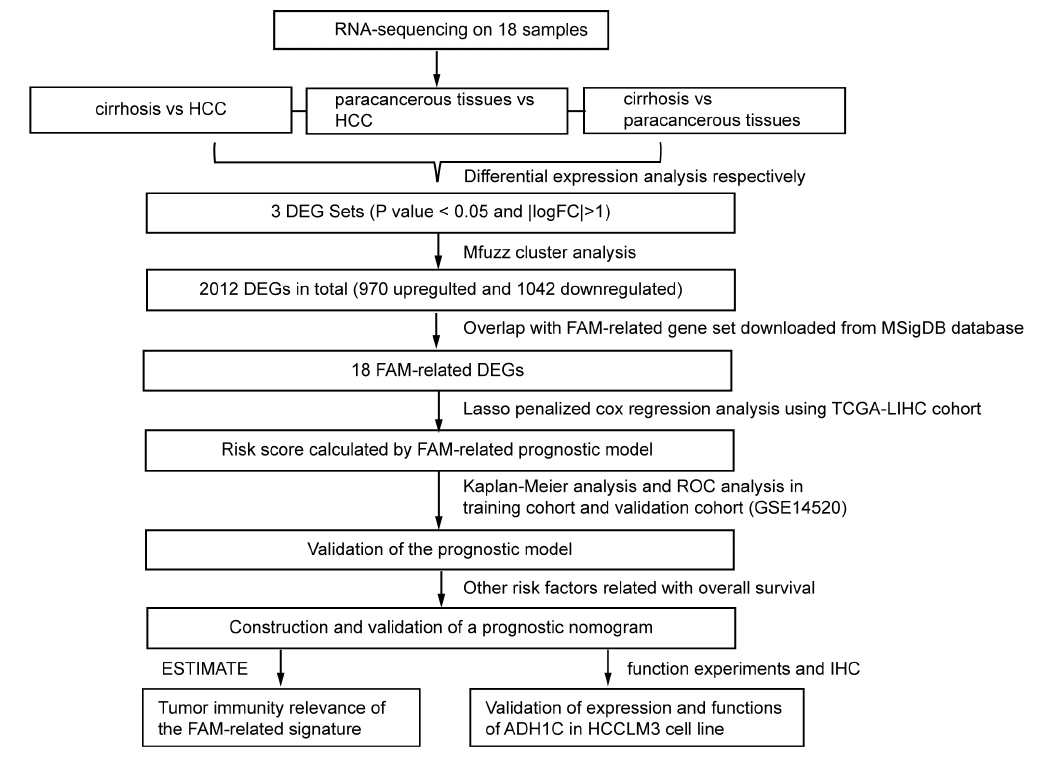
Figure 1. Flowchart presenting the process of establishing the gene signature and prognostic nomogram of cirrhotic HCC in this study.